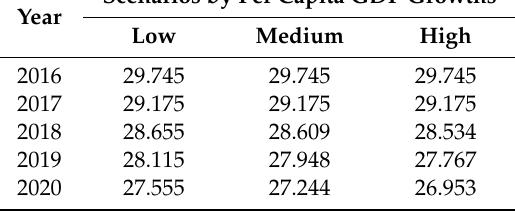
Table 3. Results of forecasting forest areas in Myanmar by using medium-level population growth and three scenarios of per capita GDP growth (unit: 10 6 ha).